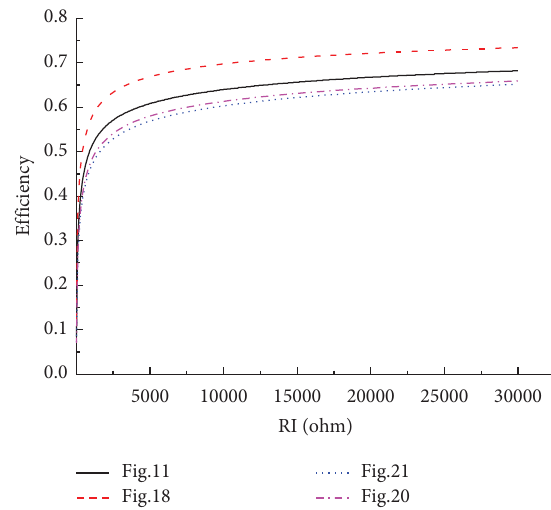
Figure 17: Te conversion efcient of various circuits shown in Figures 3, 19, 21 and